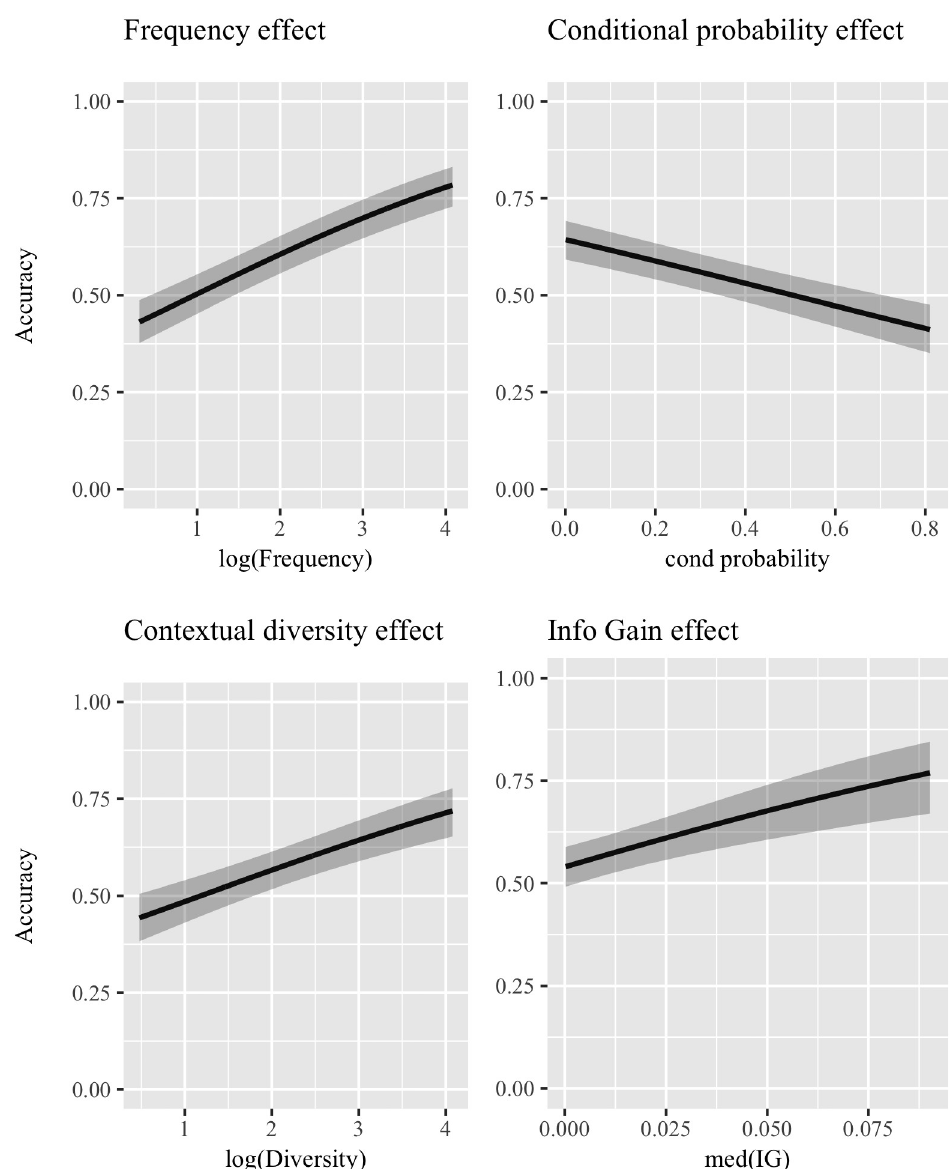
Fig 4. Logistic mixed-effect models for single predictors—Numeric overlap distance. Graphical representation of the effects highlighted by the logistic mixed-effect models which included a single predictor (inputted in the model together with Time, which is part of the baseline model) using categorization accuracy achieved with numeric overlap as distance metric as the dependent variable. Subplots are ordered according to the reduction in AIC caused by adding the predictor to the baseline model: the most important predictor is in the top-left panel, then top-right, bottom-left, and finally bottom-right. 95% confidence bands are shown.